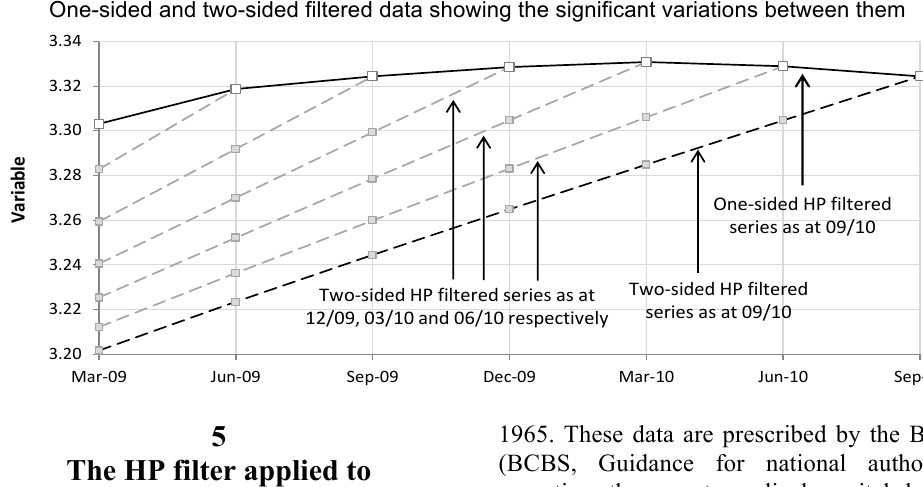
Two-­‐sided HP filtered series as at 12/09, 03/10 and 06/10 respectively